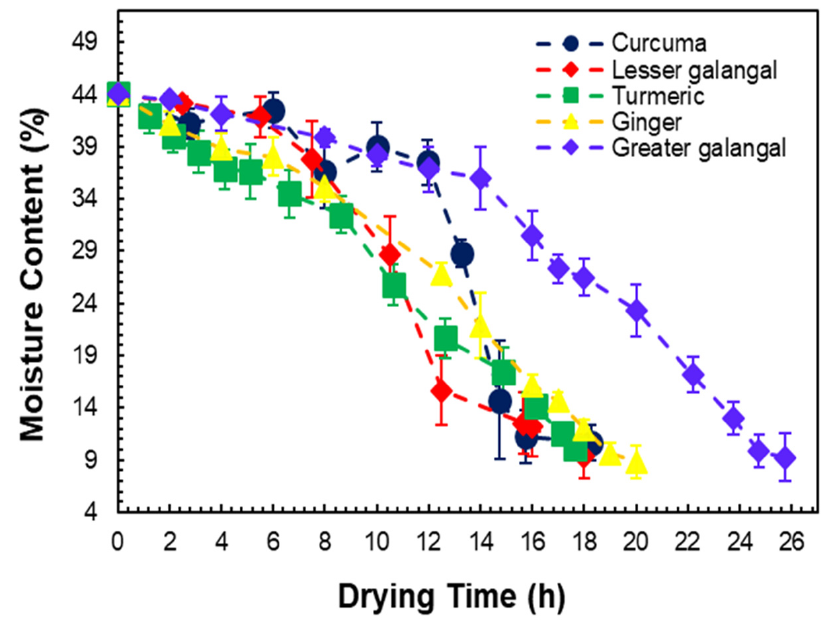
Figure 6. Drying profiles of medicinal plant samples in the Polydryer with heater operation: turmeric, ginger, greater galangal, Curcuma, and lesser galangal.